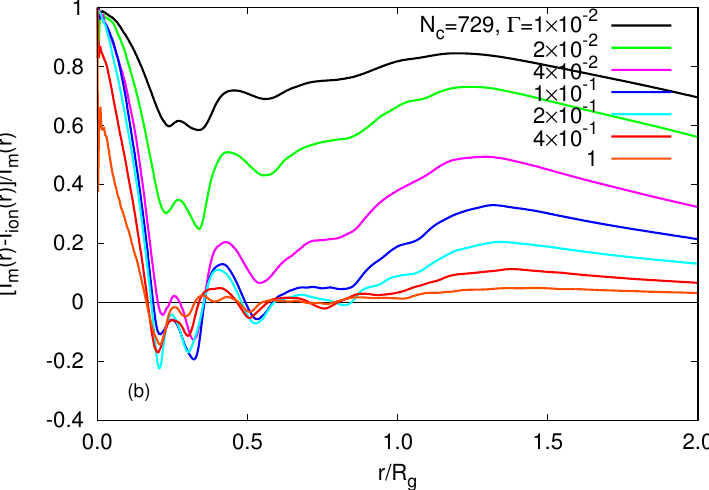
Figure 14. Ratio of the monomer-counterion charge difference and the monomer charge (cf. Equation (16)) as a function of the radial distance from the microgel center for the indicated interaction strengths and the microgel of size N c = 729 with L / l = 400. The radii of gyration of the microgels are R g / l = 67.7, 75.1, 77.1, 81.7, 82.2, 80.7 and 78.2 with increasing Γ